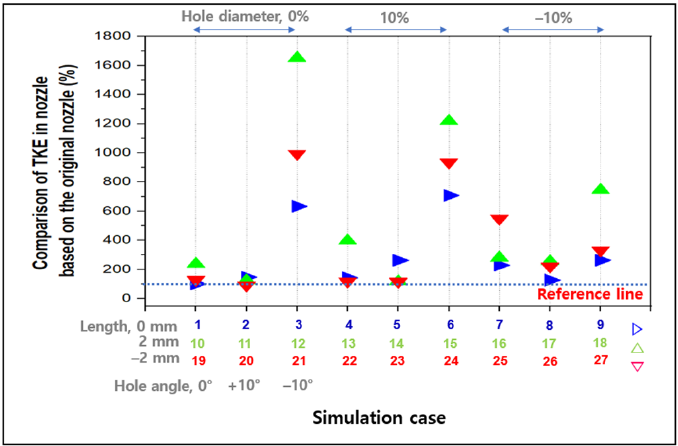
Figure 14. Comparison of TKE in nozzles based on the original nozzle.